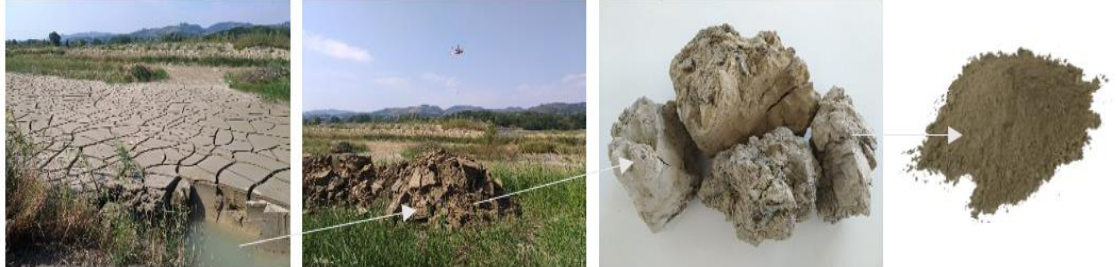
Figure 2. The washed-off silt during limestone production is stored at S.A.P.A.B.A. s.r.l.’s sedimentation lakes, where it is collected and processed for further use [6]. Table 1. Chemical composition of uncalcined silt.